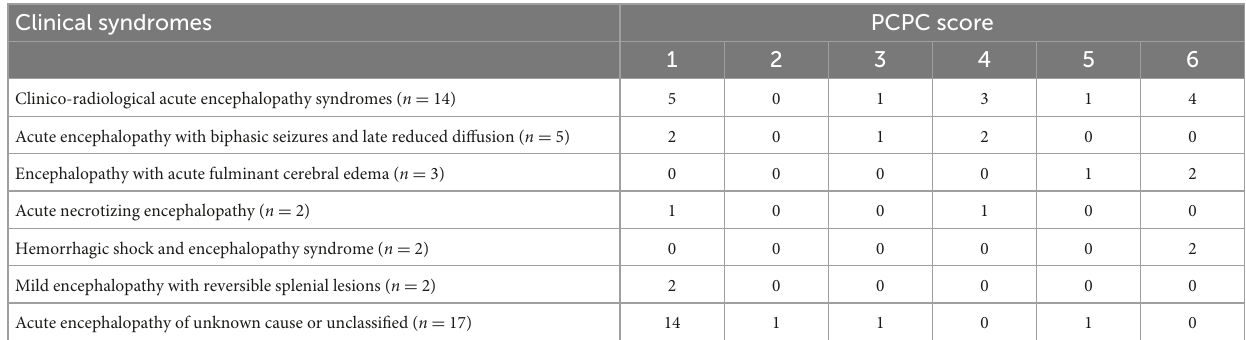
TABLE 2 Outcomes in different acute encephalopathy syndromes. Clinical